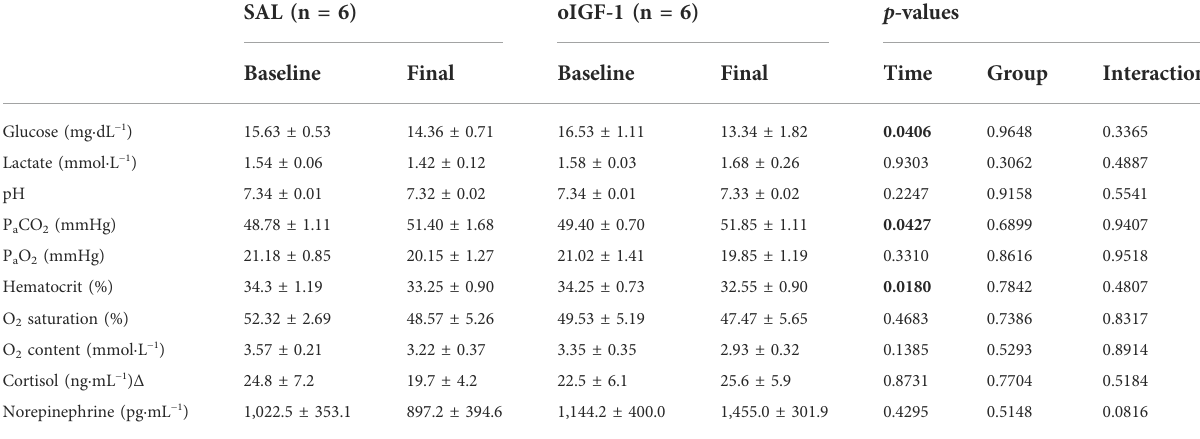
TABLE 3 Fetal glucose, lactate, blood gas, and hormone concentrations after 1-week infusion of oIGF-1 or saline